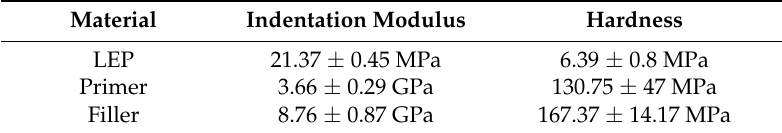
Table 4. Bulk properties obtained for LEP configuration materials with nanoindentation testing.